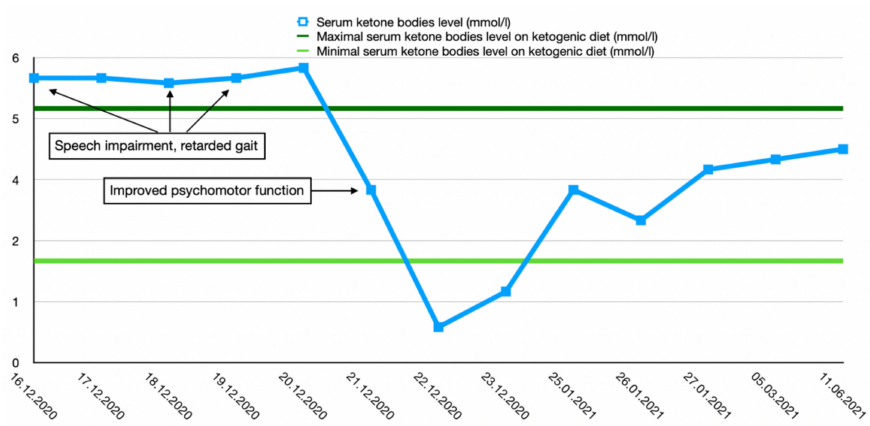
Figure 1. Serum ketone body level changes in female patient 1.